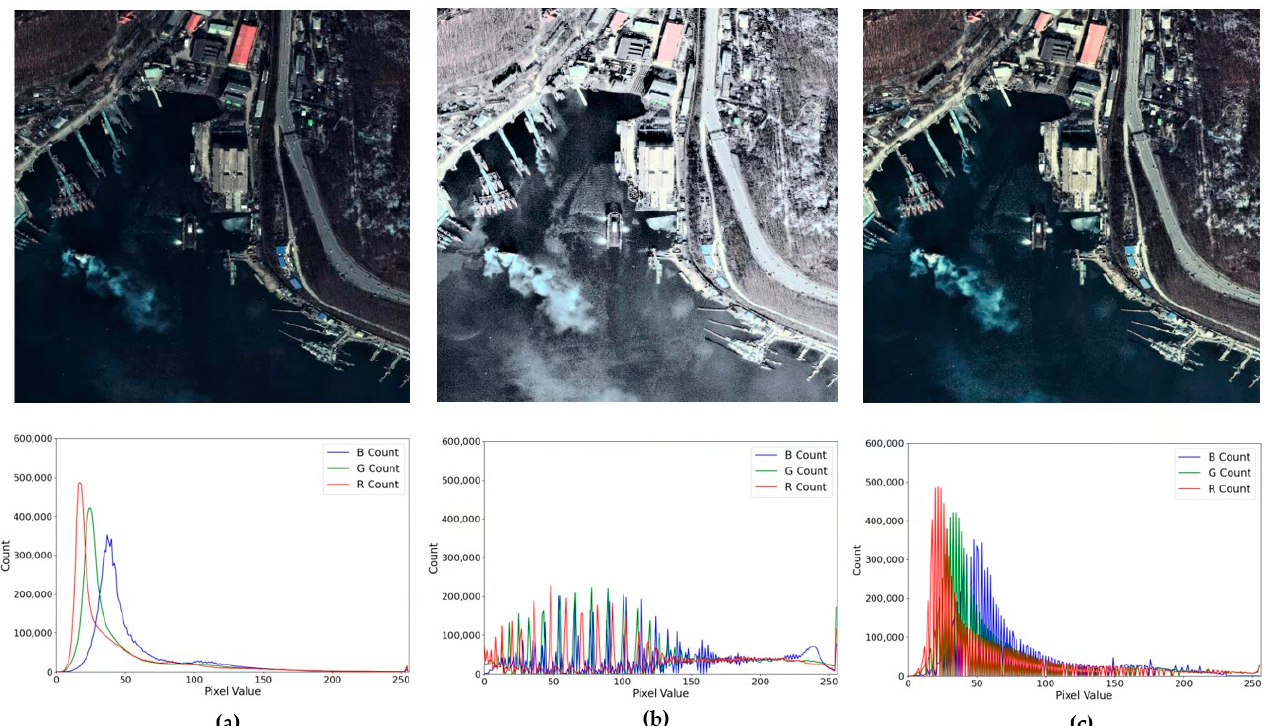
Figure 2. Histogram distribution result according to histogram equalization technique: ( a ) Original image-based histogram; ( b ) Histogram equalization of RGB channels; ( c ) GFEP-based histogram.